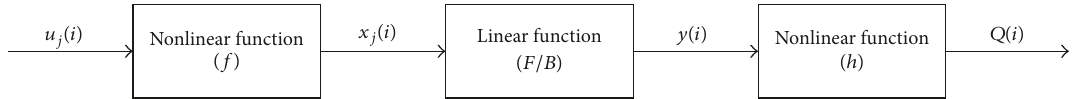
Figure 1: MISO-NHW model diagram